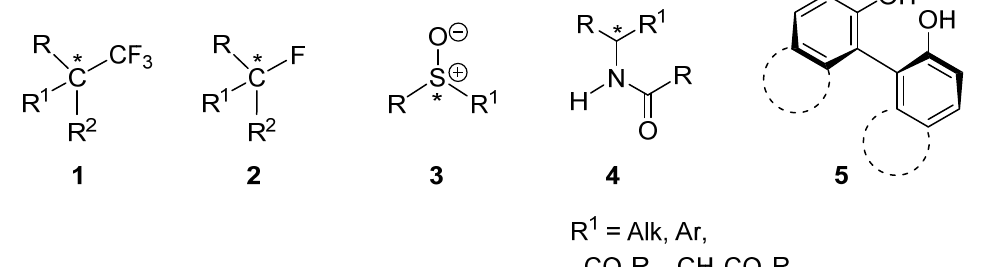
Figure 1. Examples of compounds 1 – 5 that contain SDE-phoric groups. The chiral center is marked with an asterisk in 1 – 4 , while axial chirality is present in 5 .